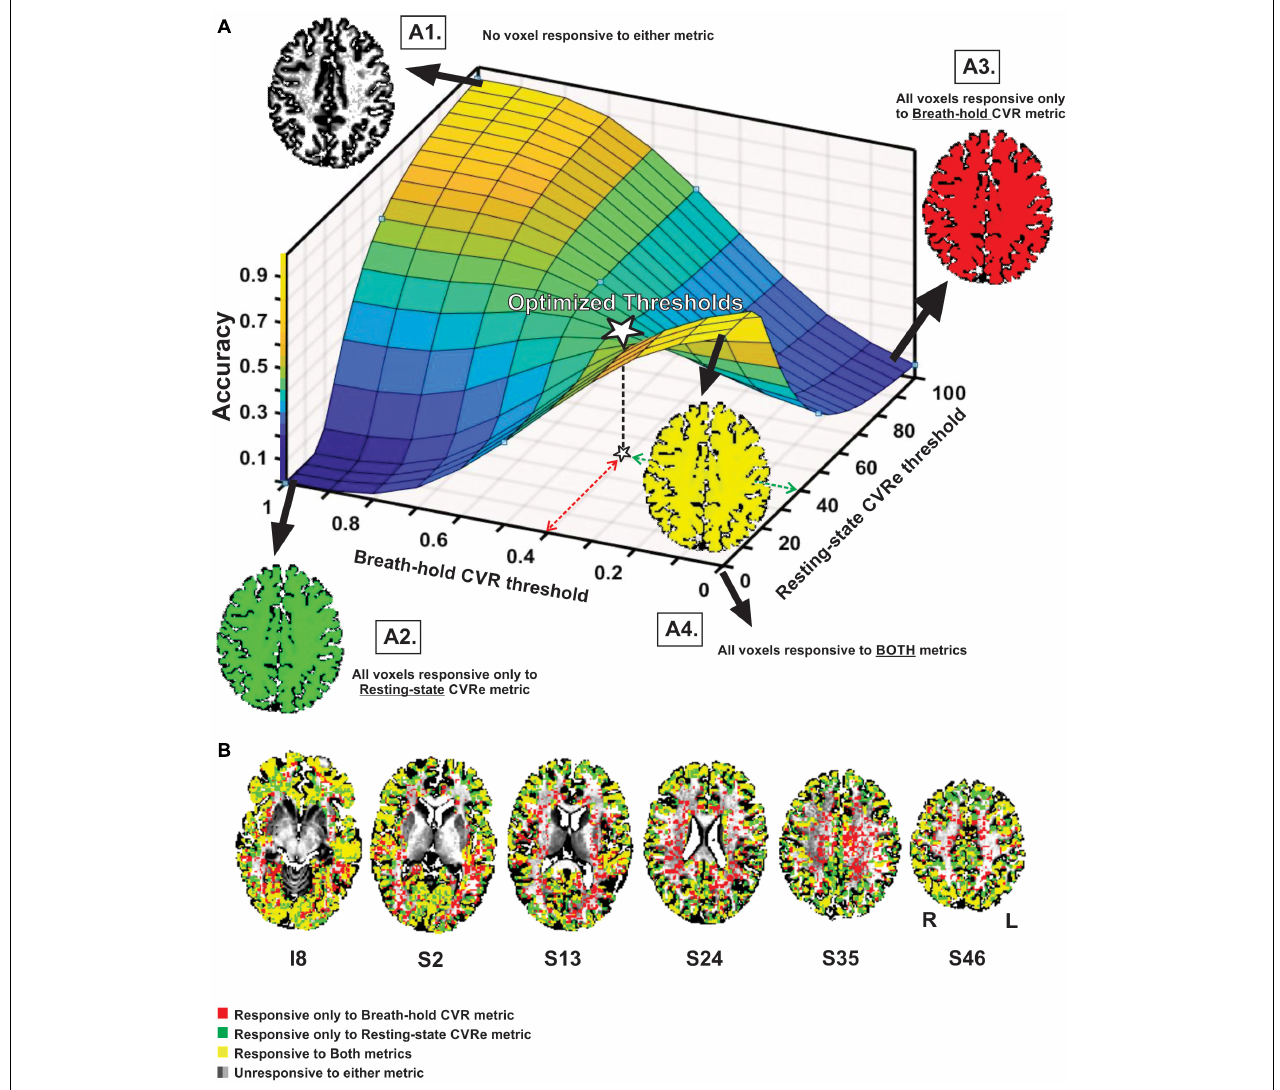
FIGURE 3 | (A) Accuracy of spatial correspondence between breath-hold CVR and resting-state CVRe within cortical gray matter as a function of threshold (beta coefficient for breath-hold and ALFF for resting-state). Optimal threshold pair that maximized segregation of CVR responses to gray matter shown by dashed red and green arrows. Accuracy for those optimal thresholds is indicated by star. Moving threshold settings toward biased corners forces all voxels to be classified as CVR responsive to one (A2, A3), both (A4) or neither (A1) CVR metric. (B) Axial brain images with overlaid CVR activation maps at optimal threshold settings (0.4 and 40 for breath-hold and resting-state CVR maps, respectively). Labeling in gray and white matter is illustrated though accuracy measures pertain to the gray matter VOI only. Voxel color code indicated at lower left. Labels under slice images indicate relative slice position in mm (I, inferior; S, superior). Labels below the slice image in the right show the orientation of all slice images (R, right; L,